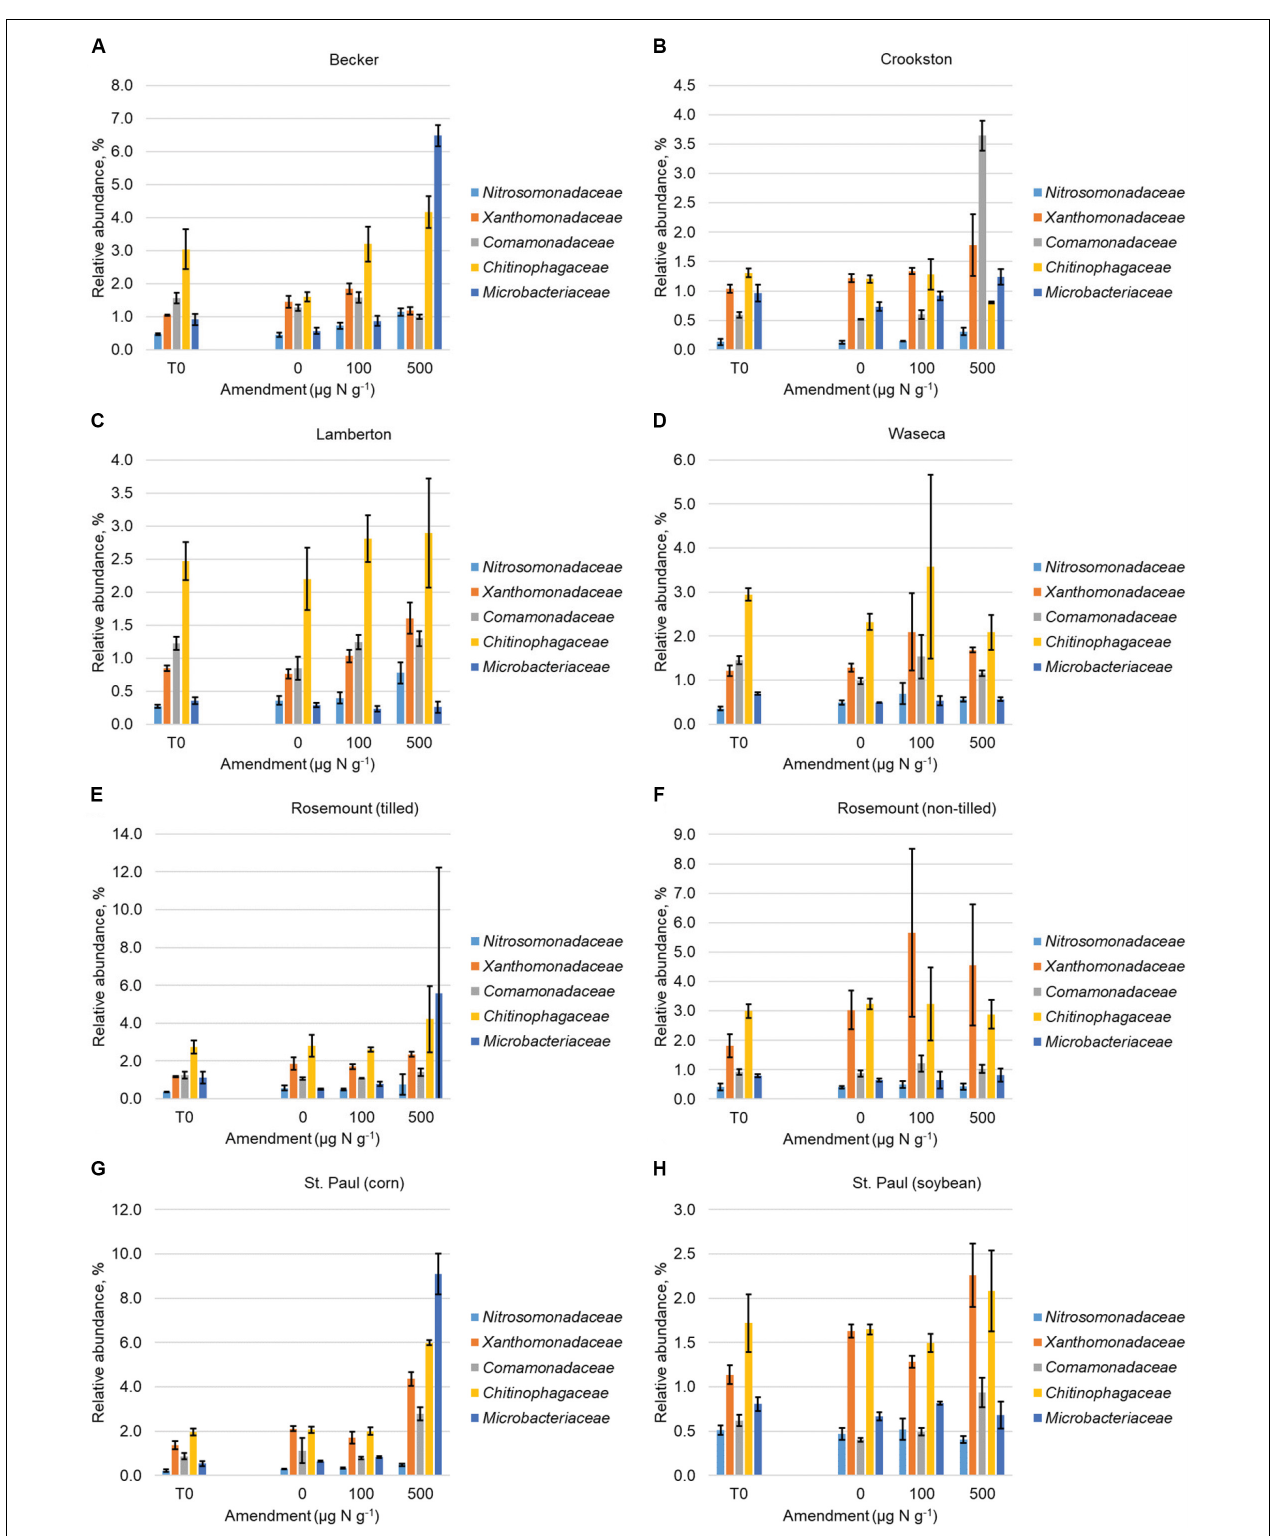
FIGURE 1 | Abundances (mean ± standard deviation) of families to which OTUs that were discriminatory for urea amendment (Supplementary Figure S3) were classified. Abundances are shown prior to urea amendment and at the 21-day time point for each amendment at (A) Becker, (B) Crookston, (C) Lamberton, (D) Waseca, (E) Rosemount (tilled), (F) Rosemount (non-tilled), (G) St. Paul (corn), (H) St. Paul (soybean).